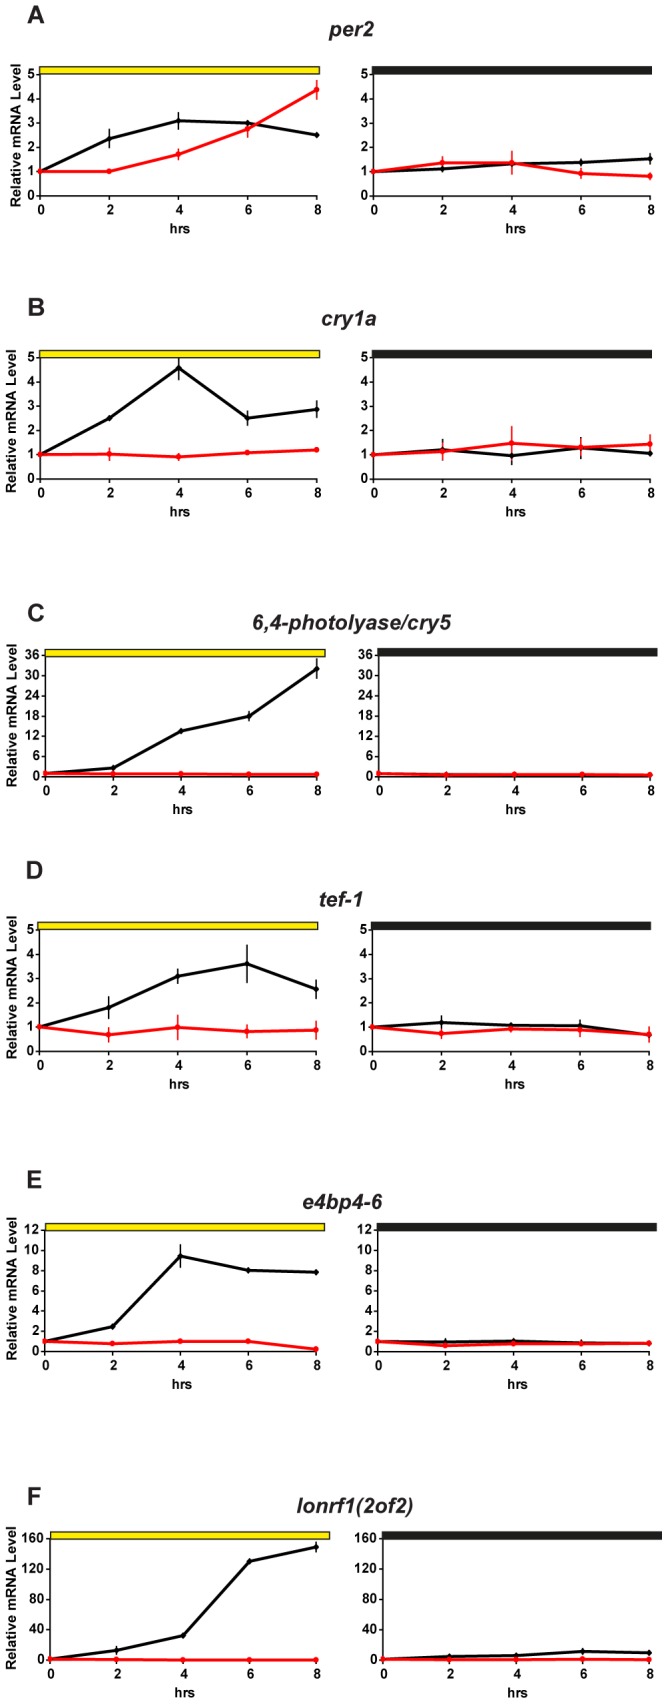
Differential effect of cycloheximide on light-induced gene expression.(A–F) Quantitative RT-PCR analysis (qRT-PCR) of light inducible genes in PAC-2 cells in the presence (red traces) or absence (black traces) of cycloheximide (CHX) during 8 hours of light exposure (left panels) or constant darkness conditions (right panels). Cells were maintained for 3 days in DD prior to the experiment. 1 h before sampling, cells were treated with CHX (10 µg/ml). Each gene is indicated above its respective panels. Yellow and black bars above each panel indicate the light and dark periods, respectively. Relative mRNA levels are plotted on the y-axes and were set arbitrarily as 1 at time-point 0 hrs for each gene. Endogenous β-actin mRNA levels were not influenced by light or cycloheximide treatment and so these were used to normalize the expression of each gene (see Figure S1 B). Time (hrs) is plotted on the x-axes. In each panel, points are plotted as the means of three independent experiments +/− SD. All statistical analyses (t-test and two-way ANOVA) are presented in Table S2. The blocking of protein synthesis by cycloheximide treatment of PAC-2 cells was confirmed in Figure S1 A.